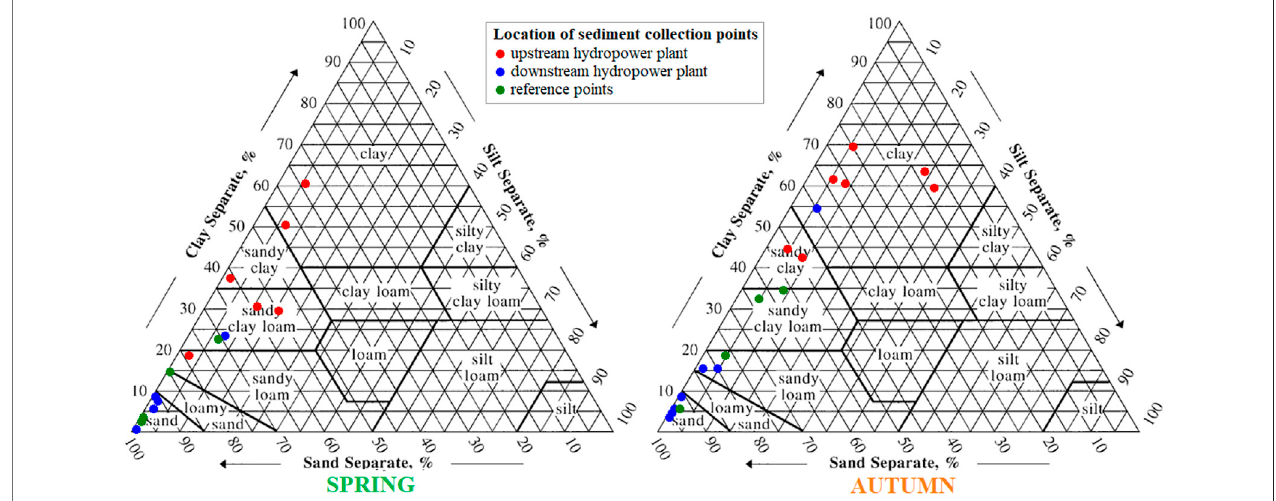
FIGURE 5 | The texture of the tested sediment from points within the hydropower plant on the Bystrzyca River.